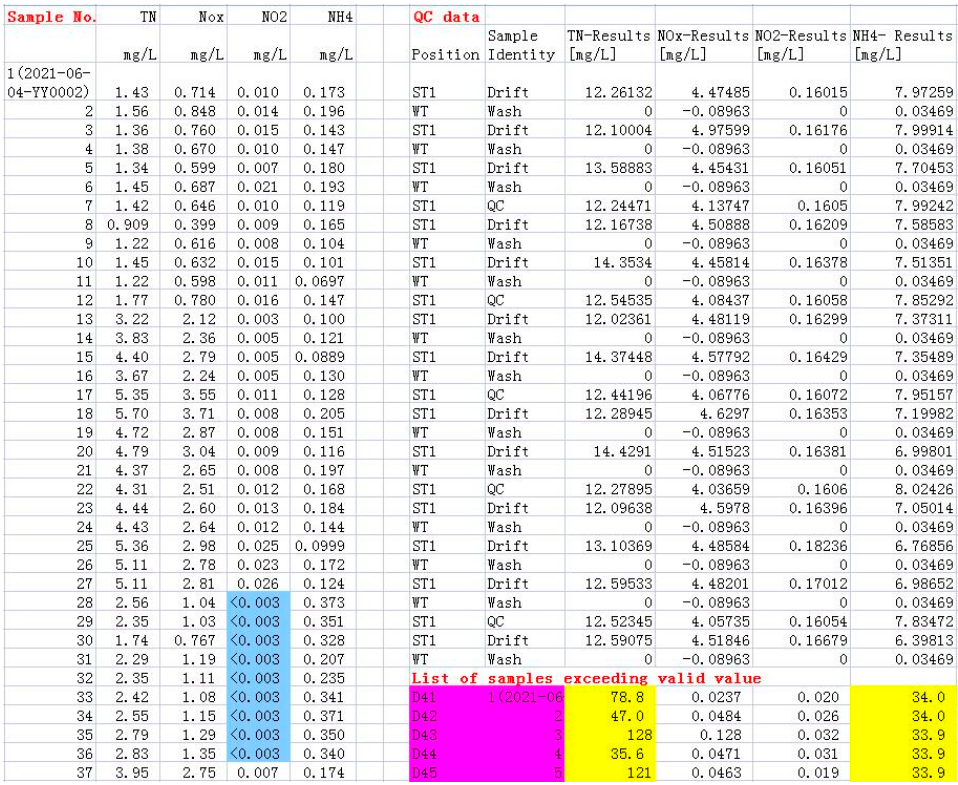
Figure 10. Data processing results. After processing the raw data, all samples are placed in sequence, and the values are processed according to three significant digits. The quality control data and the samples that exceed the standard to be diluted are displayed separately, and all processes are completed automatically. Cells with a yellow background indicate that the value exceeds the maximum effective value of the analysis item and needs to be analyzed again after dilution. Cells with a red background indicate the number of the sample and the position information on the sample disk of the CFA